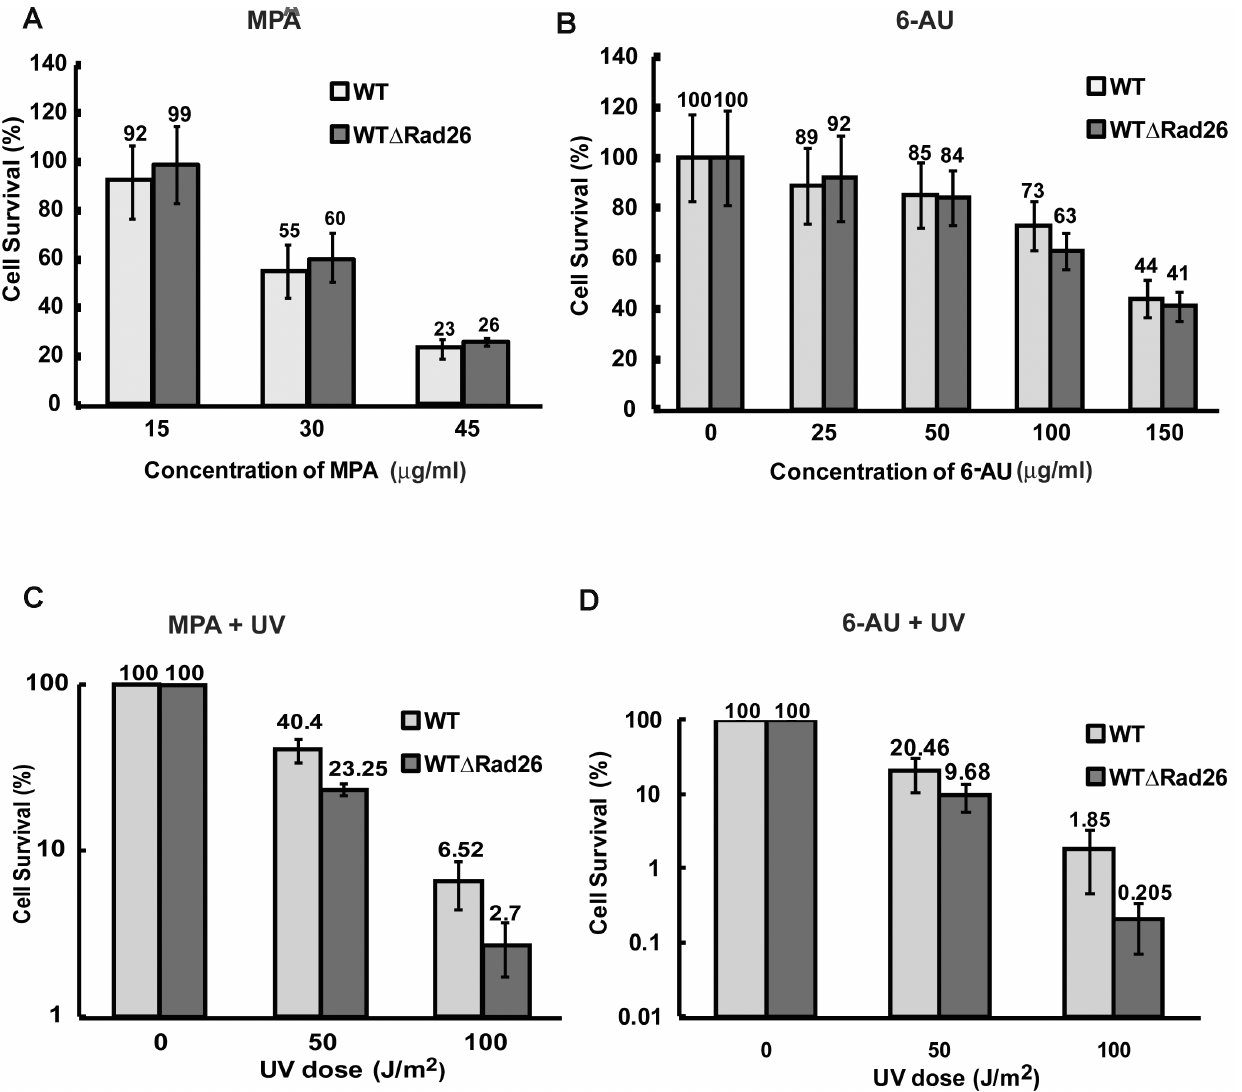
Figure 2. Sensitivity of cells to transcription elongation inhibitors with or without UV treatment. Cells of exponentially growing cultures were appropriately diluted and spread on SC plates supplemented with MPA (A) or 6-AU (B) of indicated concentrations without UV irradiation. Similarly grown cells were spread on SC plates supplemented with MPA (C) or 6-AU (D) and subjected to UV doses as indicated. Growth was monitored after 72 h. For each strain, data represent the mean 6 1 SD for four independent